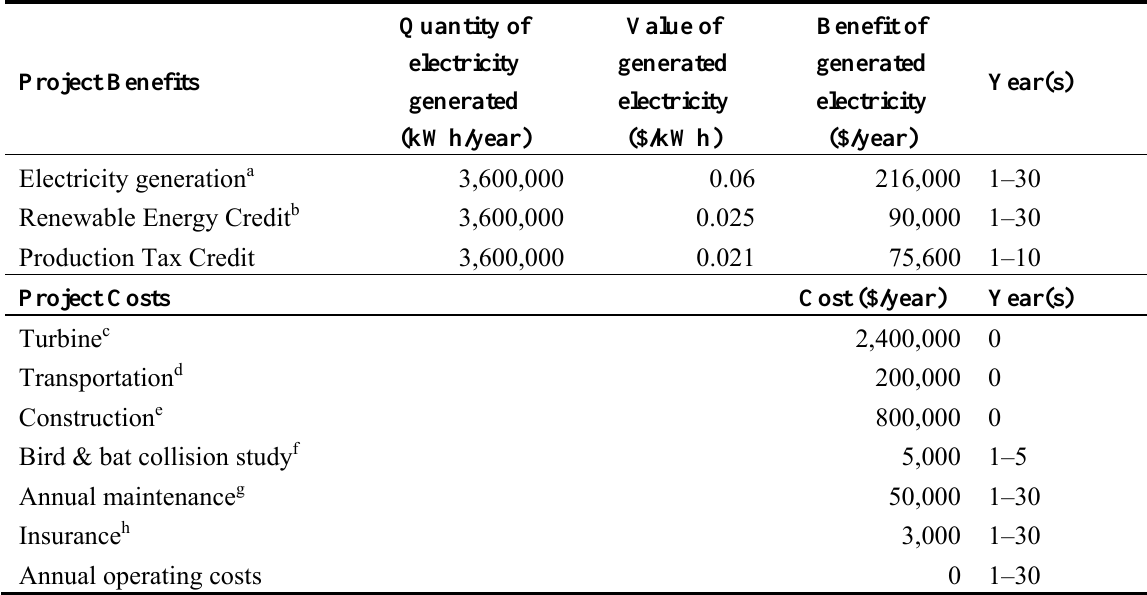
Table 2. The expected project costs and